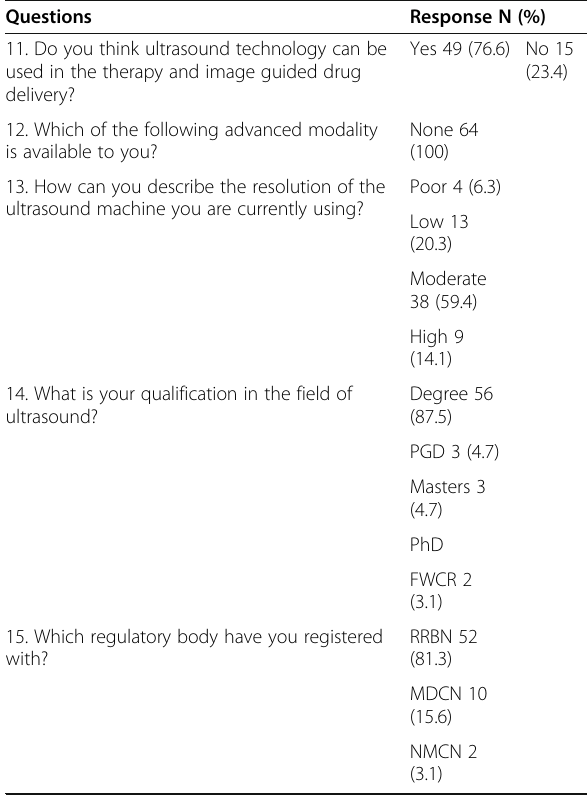
Table 2 Participant responses on their exposure to advanced ultrasound technology and standard of practice Questions